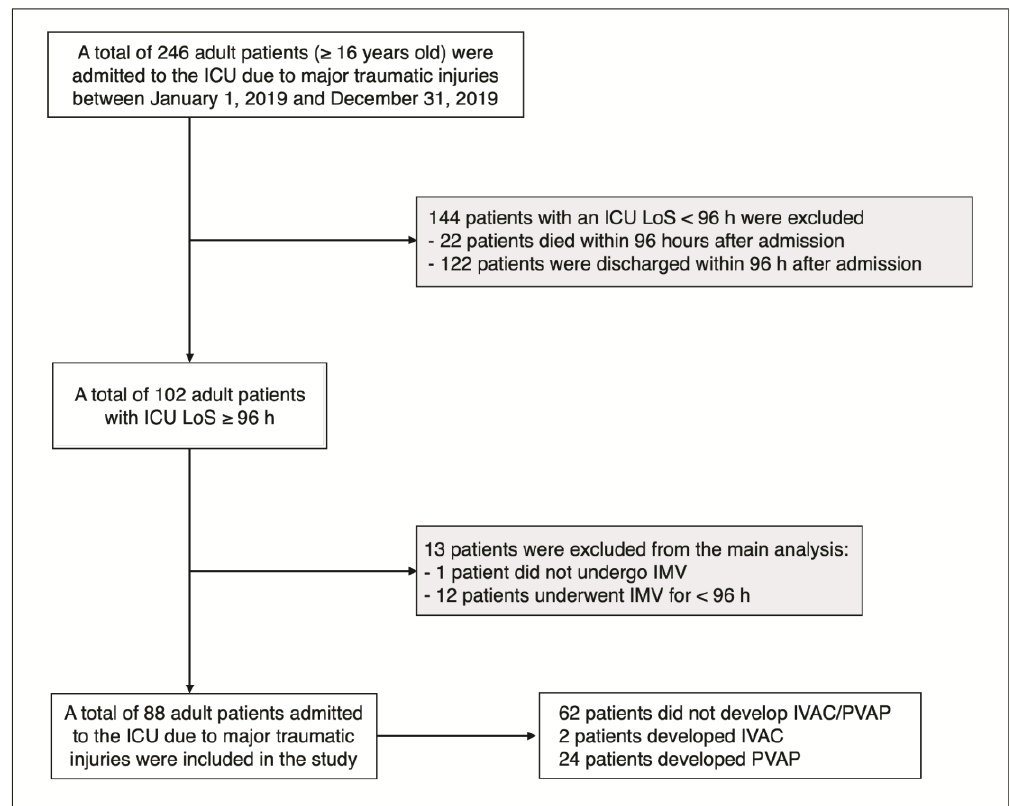
Figure 1. Flow chart of study population selection; gray boxes, subjects excluded from the main analysis (see methods). ICU: intensive care unit; LoS: length of stay; h: hours; IMV: invasive mechanical ventilation.